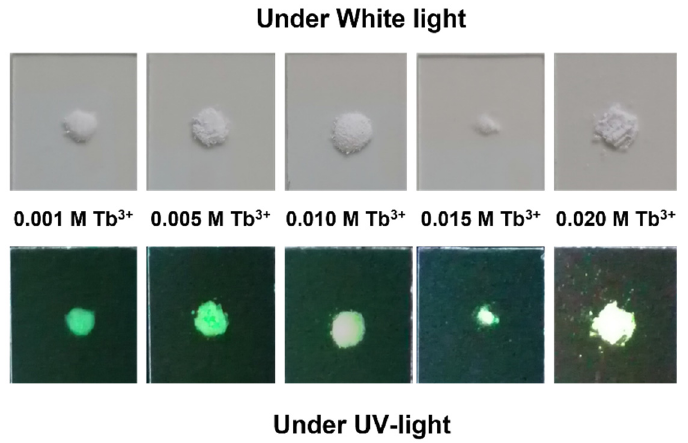
Figure 6. Pictures of samples prepared with different Tb 3+ doping concentrations ( x ) at maturation times of 96 h under sunlight ( top ) and 254 nm UV-lamp illumination ( bottom ).